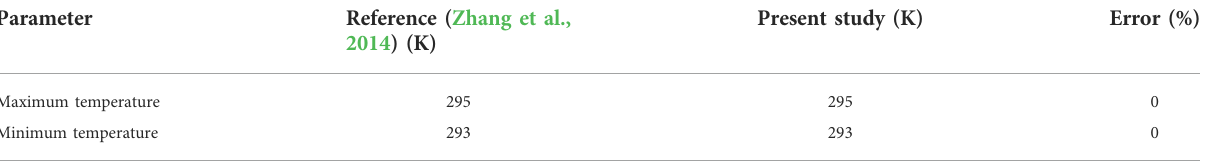
TABLE 4 Comparison between this study and study